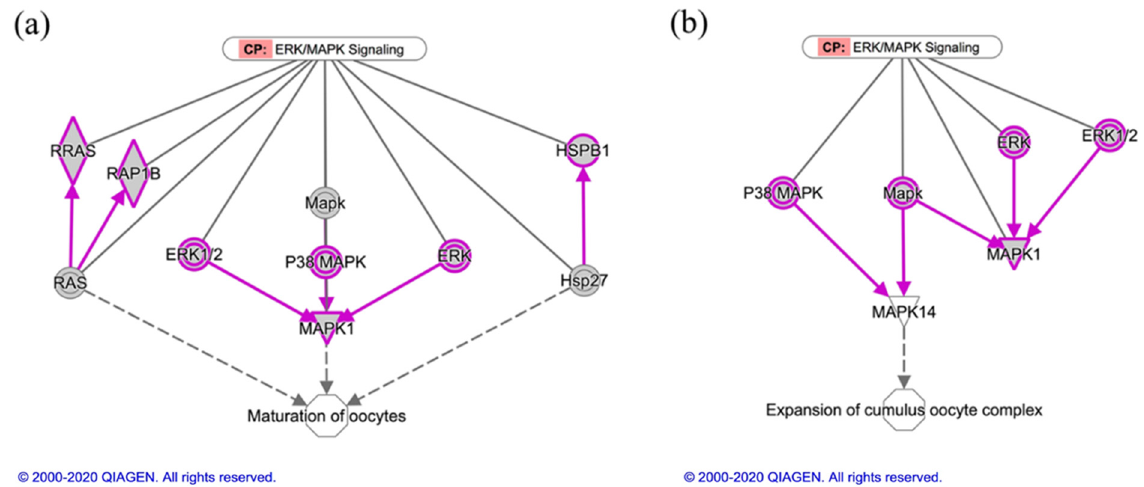
Figure 5. Molecules associated with the canonical pathway (CP) ERK/MAPK signaling in the function of two stages of oocyte development. The Ingenuity Knowledge Base defines both CPs. ( a ) The relationship between MAPKs, RAS, and Hsp27 with oocyte maturation in ERK/MAPK signaling. ( b ) The relationship between MAPKs with the expansion of the cumulus–oocyte complex in ERK/MAPK signaling. The proteins highlighted with shadowed blocks are identified in three biological samples of canine in vitro oviductal cell-derived extracellular vesicles. The solid gray lines represent the genes associated with a CP. The arrows represent the directionality of the interaction between molecules or a molecule and a bio-function. The solid line is for direct interaction, and the dashed line is for indirect interaction.